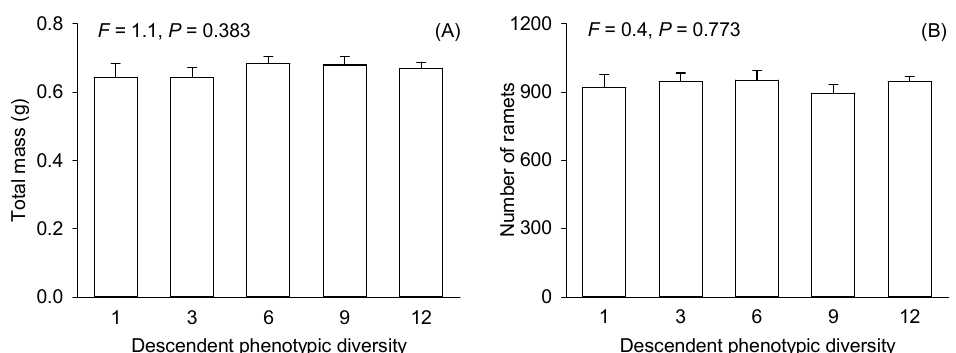
Figure 4. Total mass ( A ) and number of ramets ( B ) of Spirodela polyrhiza in response to different descendent phenotypic diversity mediated by ancestor environmental variation for the second phase of Experiment 2 . The values are means and standard errors.